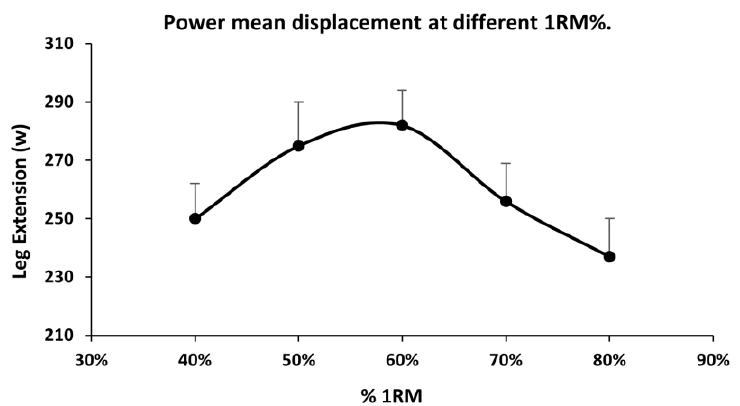
Figure 1. Mean displacement power at different percentages of 1 RM. w: wat; 1 RM: one repetition maximum; %: load percentage.